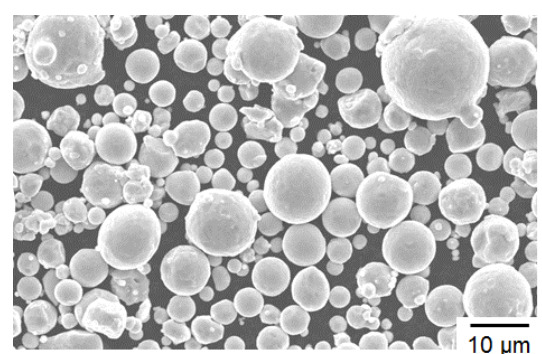
Figure 1. Scanning electron microscope (SEM) image of the powder particles studied.